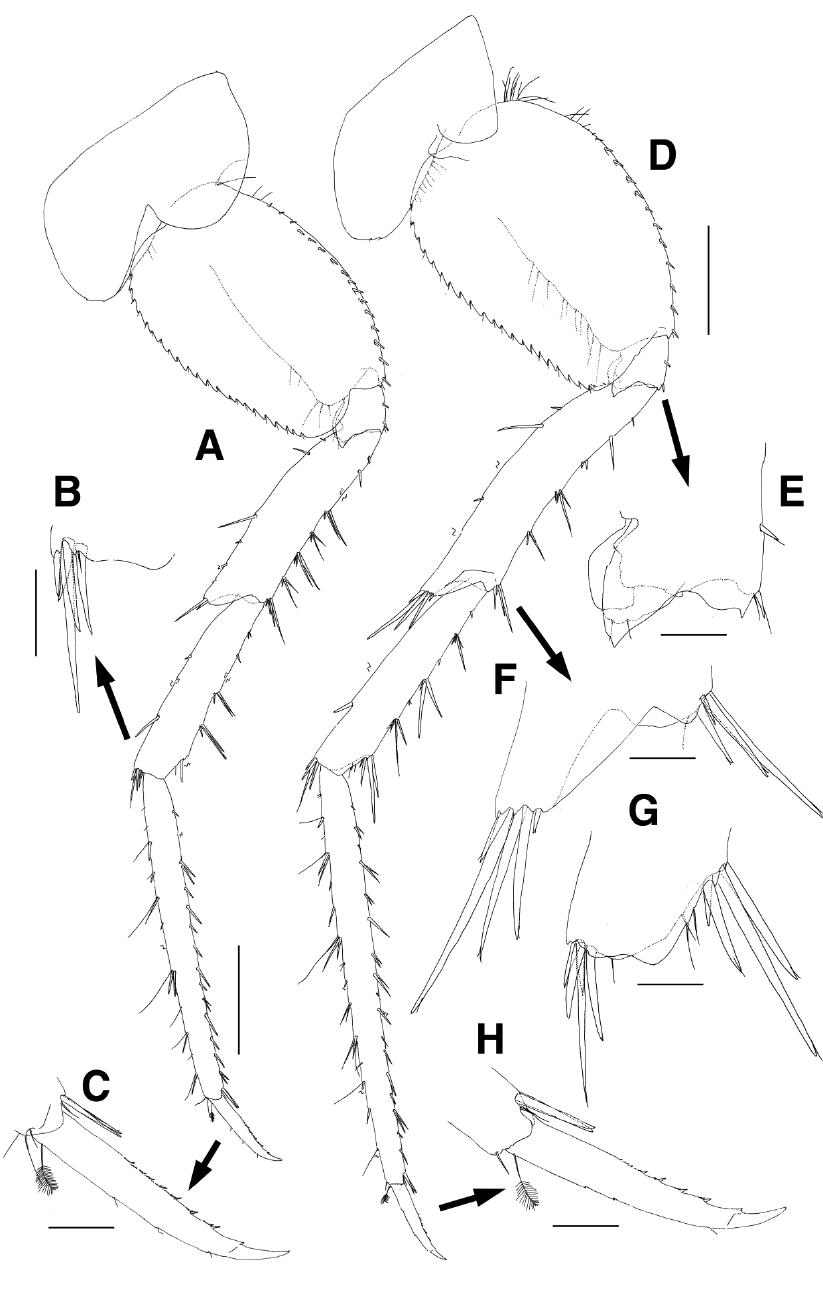
Figure 5. Eusirus bulbodigitus sp. n., holotype, male, NIBRIV0000332003, 11.3 mm. Jeju Island, South Korea. A Pereopod 5 B Posterodistal setae of carpus on pereopod 5 C Dactylus of pereopod 5 D Pereopod 6 E Ischium of pereopod 6 F Distal part of merus on pereopod 6 G Distal part of carpus on pereopod 6 H Dactylus of pereopod 6. Scale bars=0.1 mm ( B, C, E–H ), 0.5 mm ( A, D